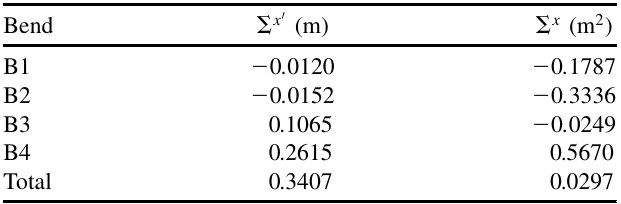
TABLE VI. Contributions to the quantities (C19) that deter- mine the relative CSR-induced emittance growth due to each of the four bends of the Berlin-Zeuthen benchmark